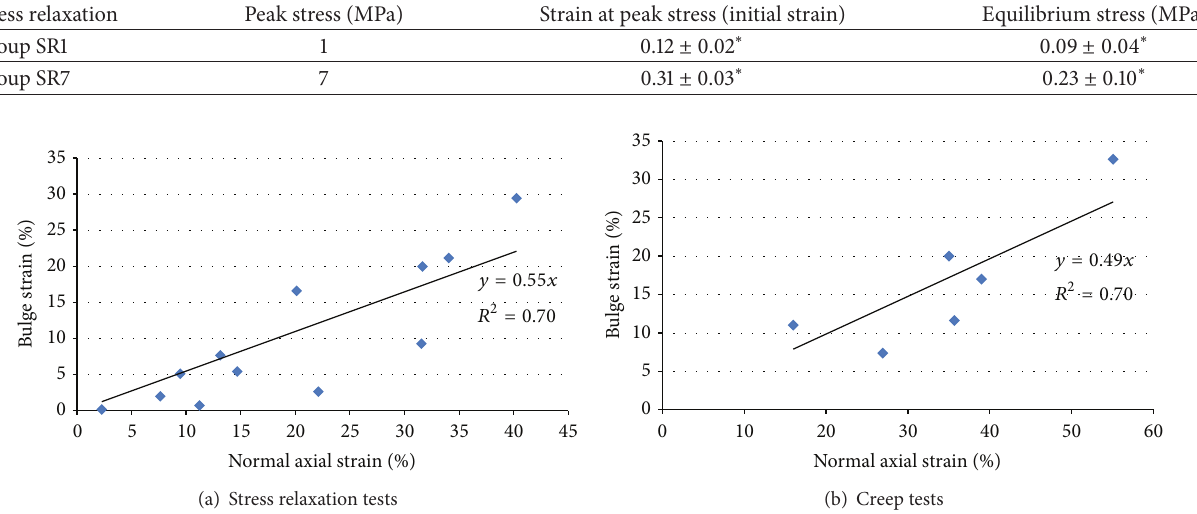
Figure 3: A plot of the bulge strain versus normal axial strain for (a) the stress relaxation tests and (b) creep tests, only for Group C1. There is a relatively good correlation between both parameters as indicated by the linear fit.